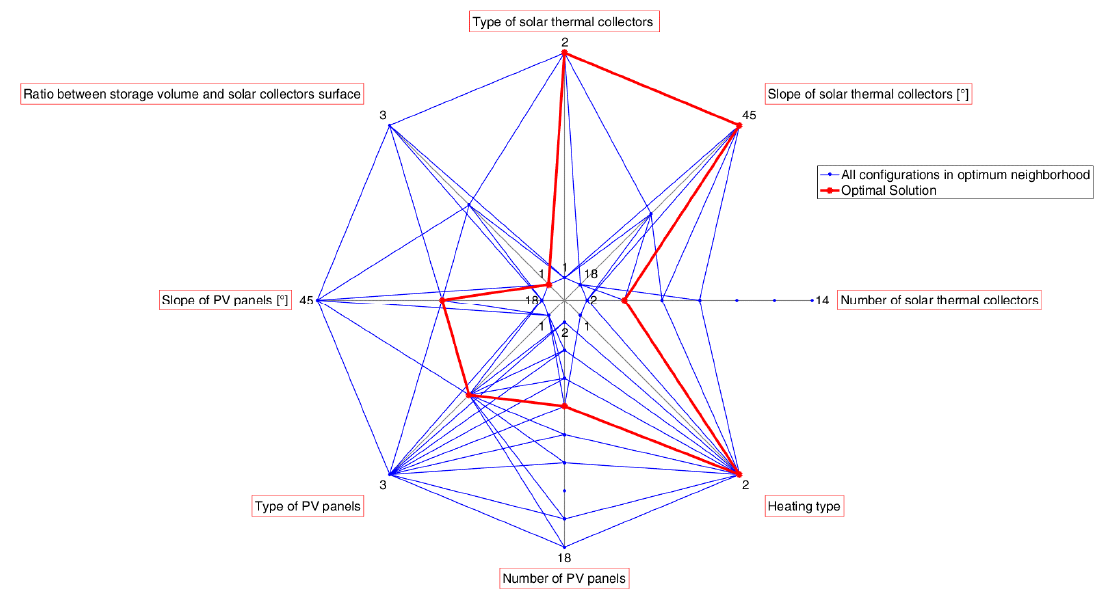
Figure 11. Design configuration networks: cost optimal neighborhood, sequential optimization, energy supply.